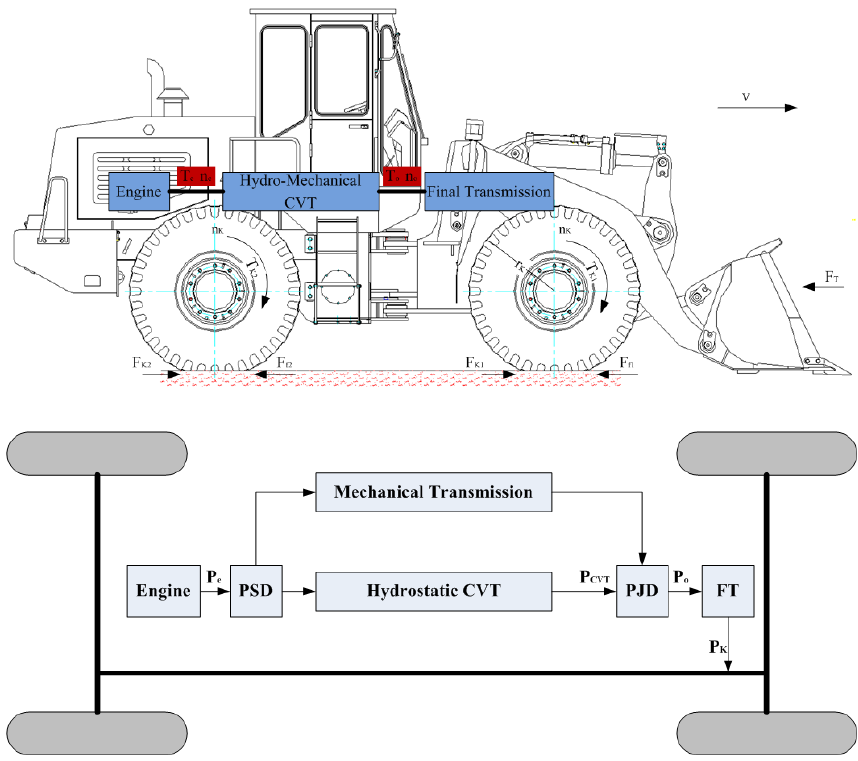
Figure 2. Force sketch of loader.